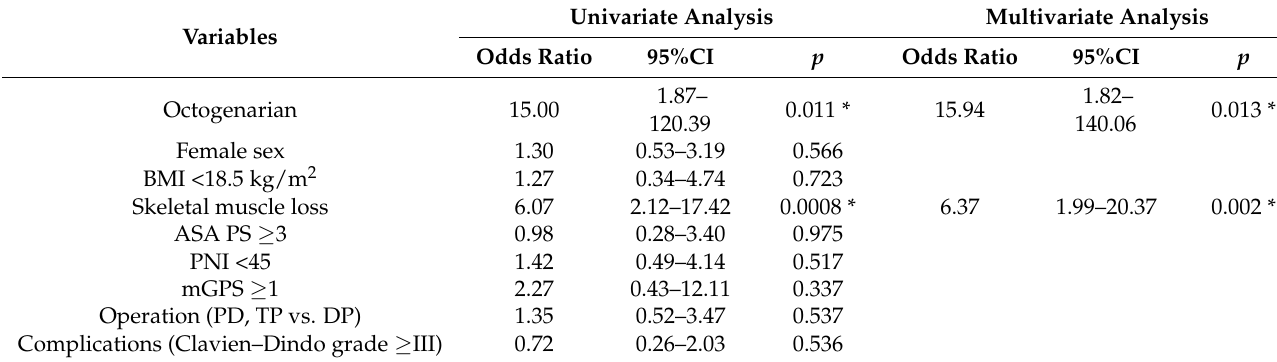
Table 3. Univariate and multivariate analyses of variables for the discontinuation of S-1 adjuvant therapy.